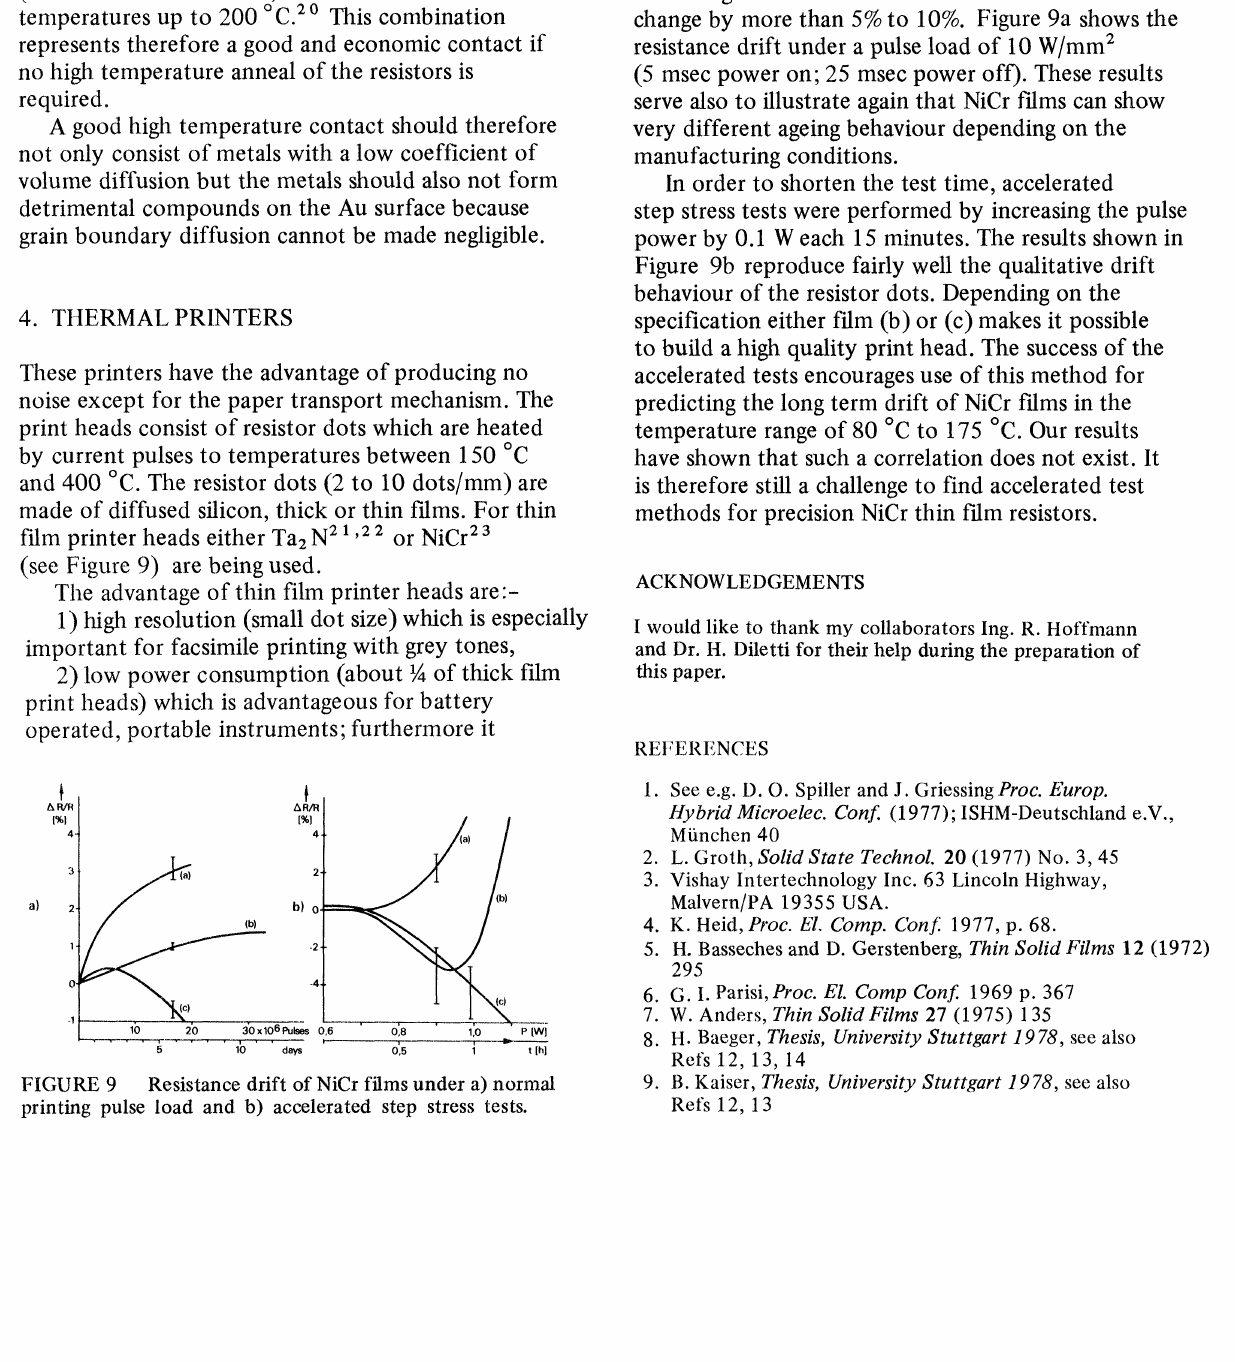
Resistance drift of NiCr fgms under a) norm printg pulse load and b) accelerated step stress